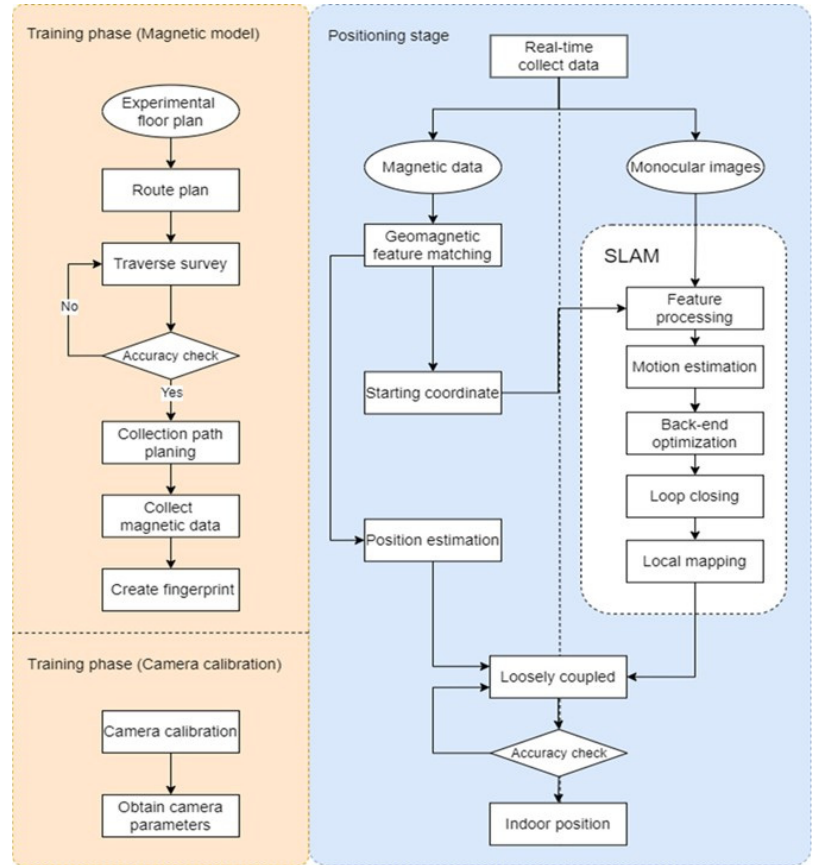
Figure 3. Research process ( left represents training stage; right represents positioning stage).